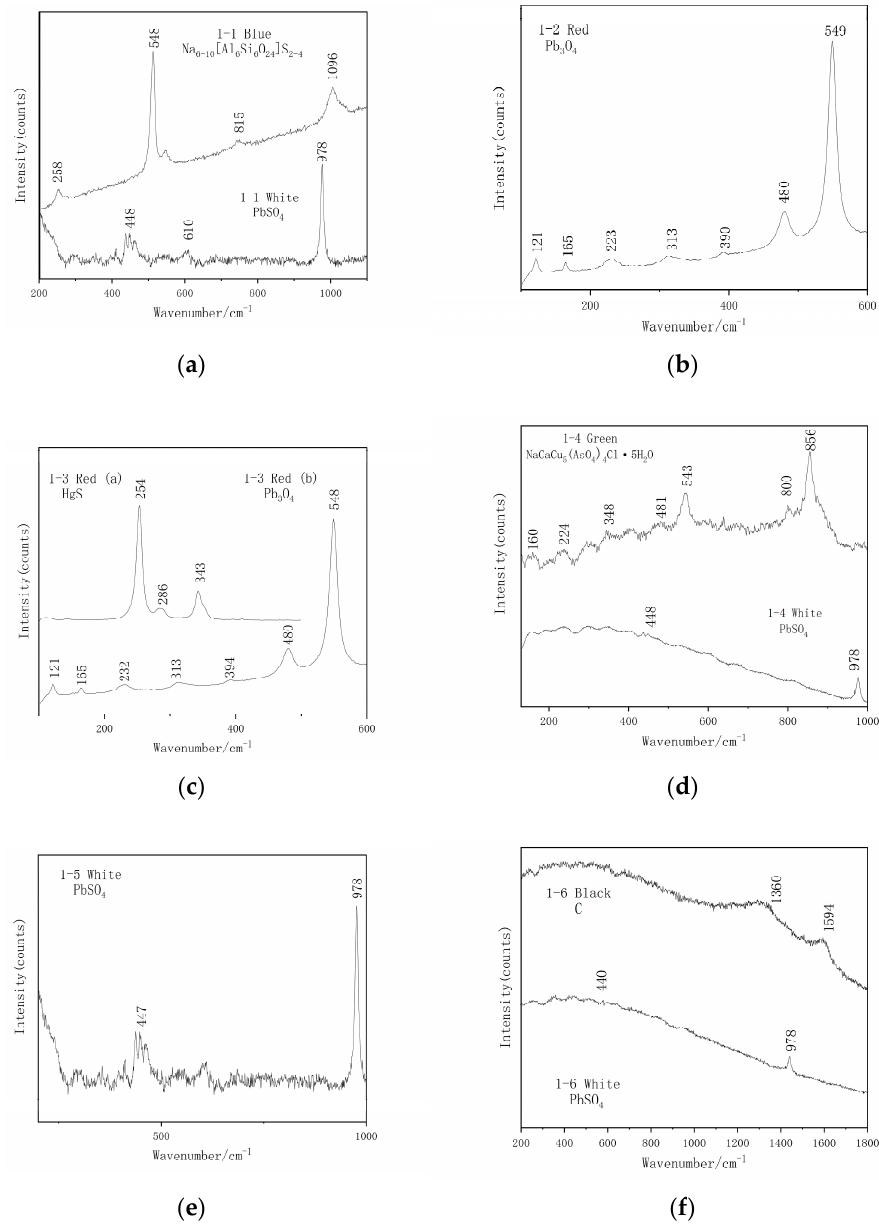
Figure 7. Raman spectra from statue No.CS1, Sage Mother Hall. ( a – f ) Characteristic peaks for Samples 1-1 − 1-6.